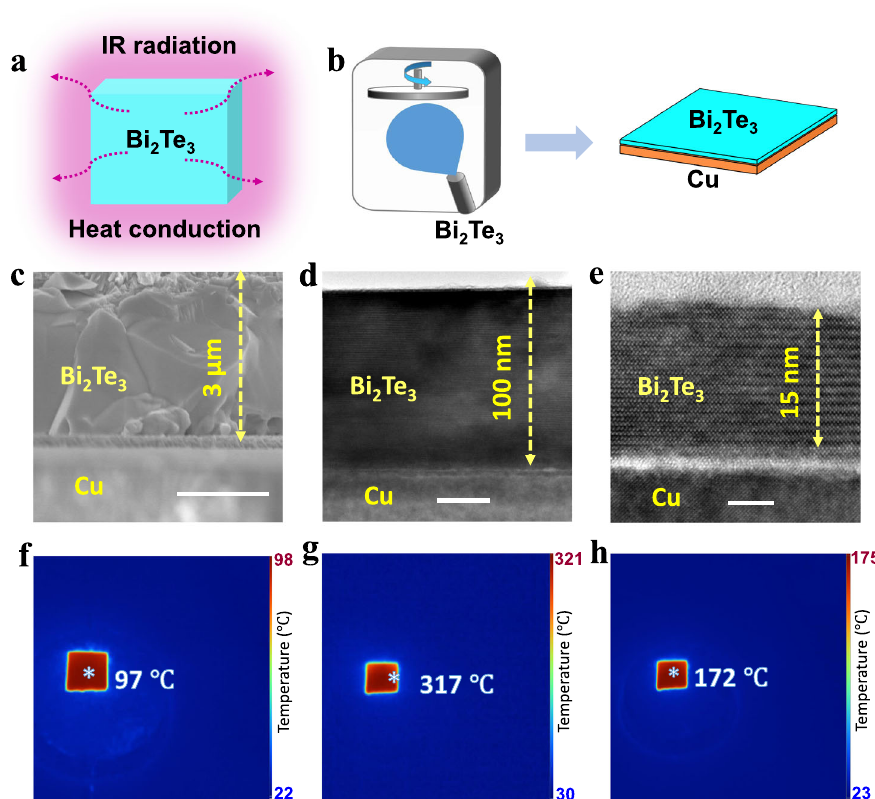
Fig. 1 Heterostructure strategy used to increase the solar irradiation temperature of Bi 2 Te 3 . a Map of the heat dissipation of the pure Bi 2 Te 3 fi lm. b Synthesis of the Bi 2 Te 3 thin fi lm on a Cu support (Bi 2 Te 3 /Cu). c – e SEM and TEM images of Bi 2 Te 3 /Cu with 3 μ m-, 100 nm-, and 15 nm-thick Bi 2 Te 3 . f – h IR images of vacuum-protected Bi 2 Te 3 /Cu with 3 μ m-, 100 nm-, and 15 nm-thick Bi 2 Te 3 . A CaF 2 glass fully covered each sample, and the vacuum degree of this equipment was 1.0 × 10 − 3 Pa. The scale bars in c , d , and e are 1500, 30, and 5 nm,